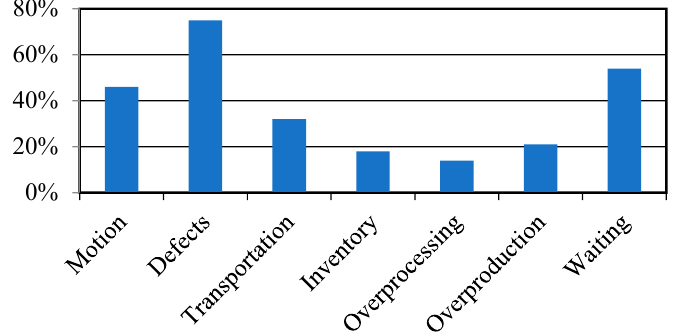
Figure 10. Percentage of responses regarding the most common type of waste which can be found in construction.